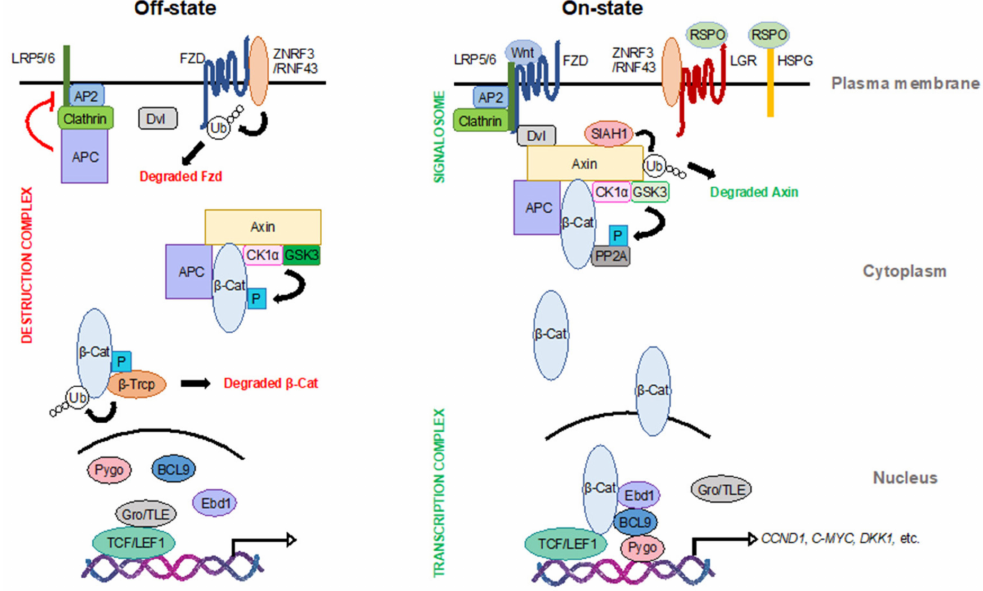
Figure 1. ThecanonicalWntsignalingpathway. IntheWntoff-state(left), β -catenin, thepivotaltranscription coactivator of the Wnt pathway, is degraded by the destruction complex in the cytoplasm. Other Wnt effectors, such as frizzled (Fzd) at the membrane and T cell factor (TCF) / lymphoid enhancer-binding factor 1 (LEF1) transcription factors in the nucleus, are also inhibited to maintain low Wnt activity. In the Wnt on-state (right), Wnt ligands trigger the formation of the signalosome to promote Wnt signal